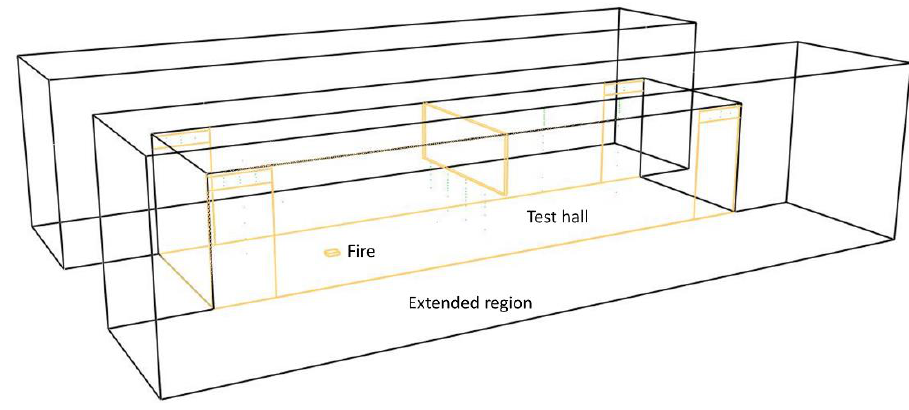
Figure 3. Isomeric view of the computational domain for Configuration 2 .